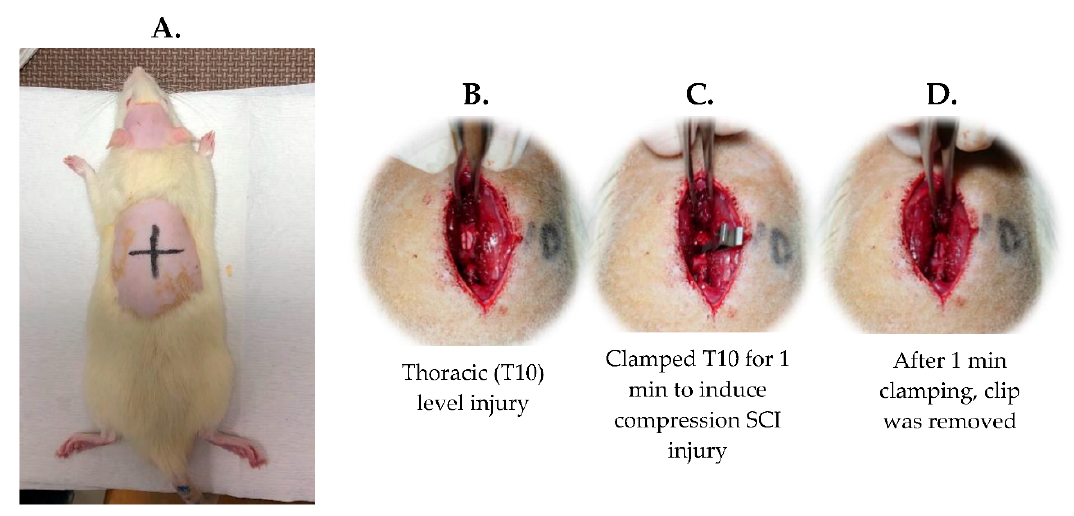
Figure 11. Surgical procedure to induce T10 spinal cord injury. ( A ). Preparation of the rat before the surgery; ( B ). Exposure of thoracic (T10) spinal cord segment; ( C ). T10 level spinal cord was clamped to induce SCI; ( D ). 1 min compression of spinal cord induced compression injury in